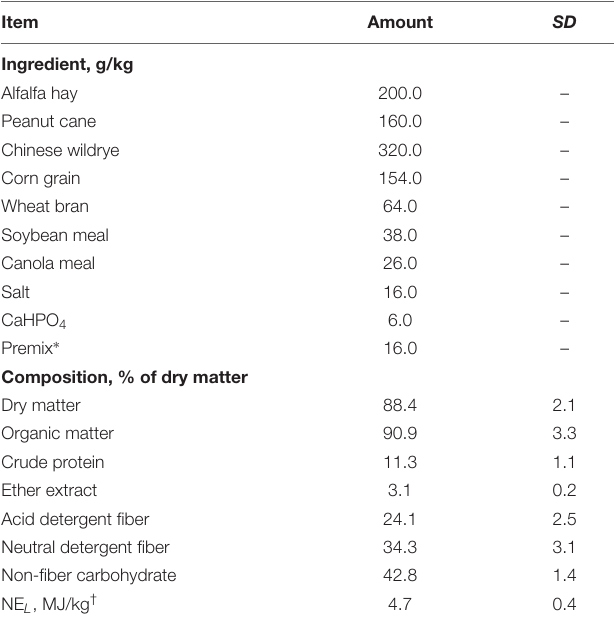
TABLE 1 | Ingredient and chemical compositions of the basal diet (dry matter